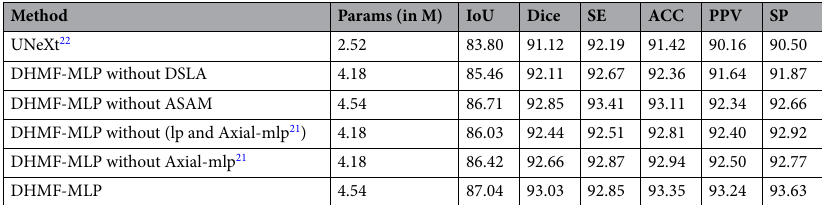
Table 6. Ablation studies of the proposed blocks on the GlaS dataset.